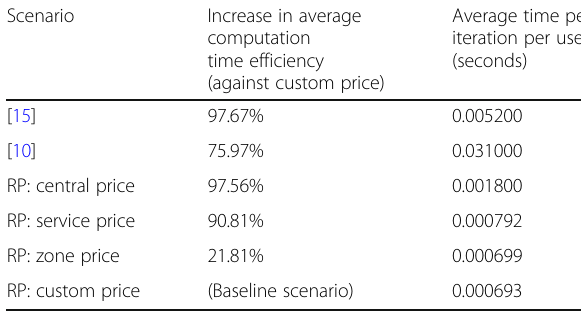
Table 1 Comparative results for computation time